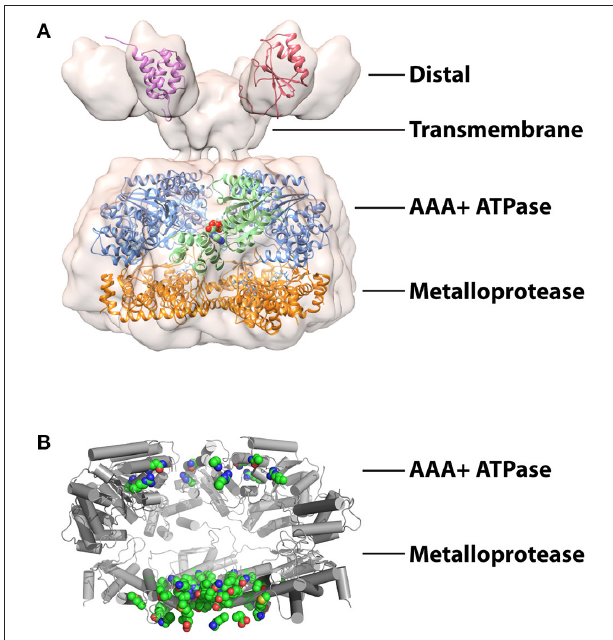
FIGURE 2 | Structures studies of mitochondrial AAA proteases (A) Combined structural information on the mitochondrial AAA proteases. A 12 Å resolution cryoEM envelope is shown from full-length S. cerevisiae Yta10/12 (EMD-1712; Lee et al., 2011). Crystal structure of the AAA + domain of human paraplegin bound to ADP at 2.2 Å (green) (2QZ4; Karlberg et al., 2009). Crystal structure of the truncated FtsH from T. maritima at 2.6 Å (AAA + domains, blue; protease domains, orange) (3KDS; Bieniossek et al., 2009). Solution structures of IMSD from human AFG3L2 at (red) (2LNA; Ramelot et al., 2013) and ND from S.cerevisiae Yme1 (pink) (2MV3; Scharfenberg et al., 2015). The figure was produced using UCSF Chimera ( Pettersen et al., 2004). (B) Structure of T. maritime FtsH (3KDS) (Bieniossek et al., 2009) showing the positions of 17 mutations identified in SCA28 (green